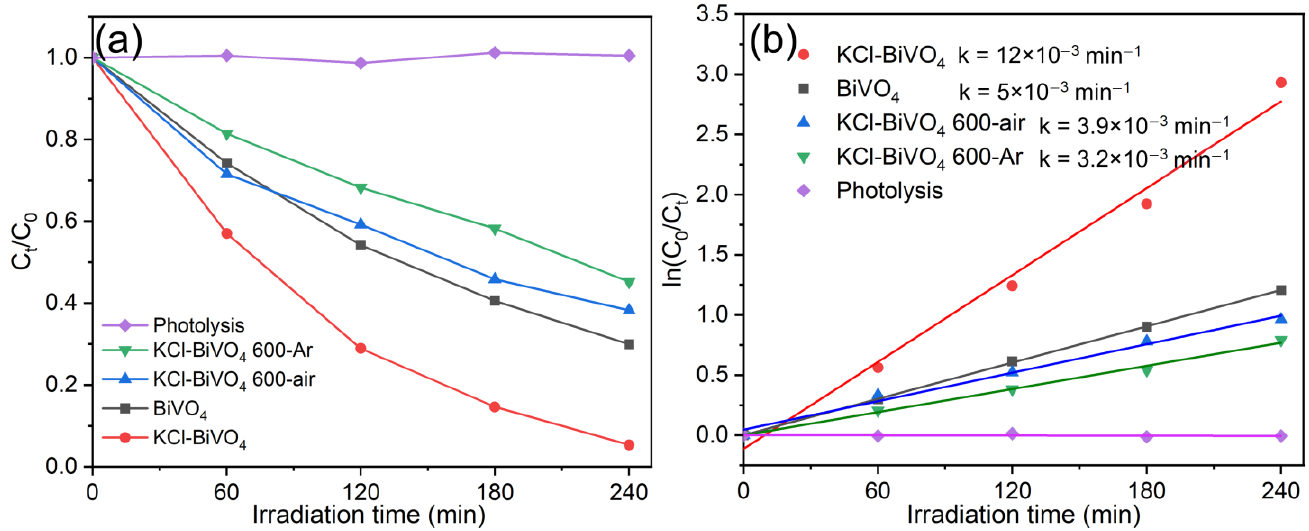
Figure 9. ( a ) Photodegradation of RhB solution with various samples under visible light ( λ > 420 nm) and ( b ) Pseudo-first-order kinetic degradation rate (k) of RhB for each sample.